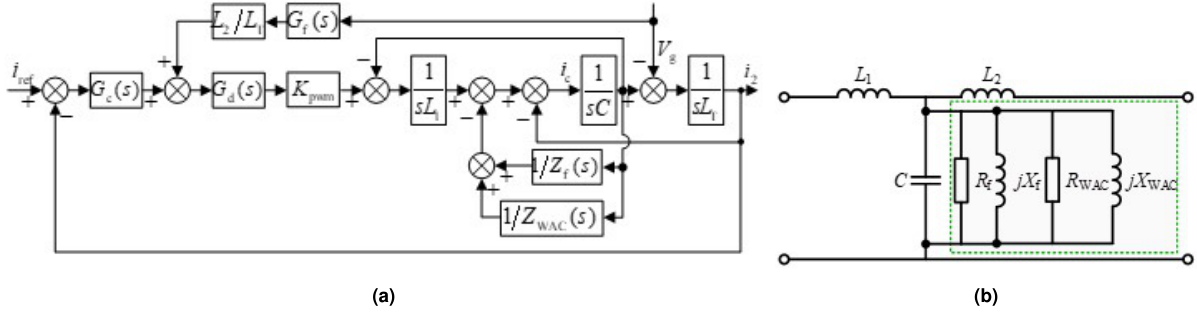
Fig. 5. Simplified system structure diagram and equivalent circuit model of CCFAD control. (a) Grid connected inverter CCFAD control simplified system structure diagram. (b) The equivalent circuit model of grid-connected inverter. LCL filter, and